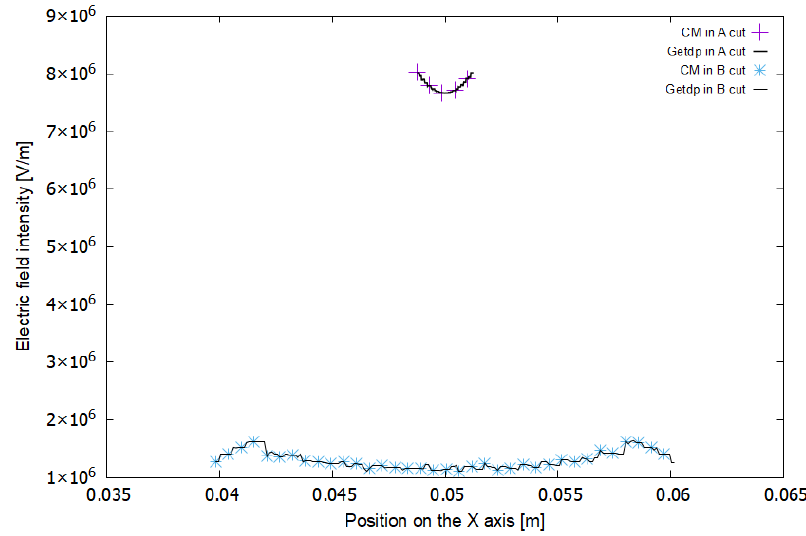
Figure 18. Electric field in cut A (upper curves) and cut B (lower curves) for experiment E3. A high-density mesh was used in experiment E3. In Figures 17 and 18, there are no differences in the values given by the FEM–getdp and CM for either the voltage or the electric field.